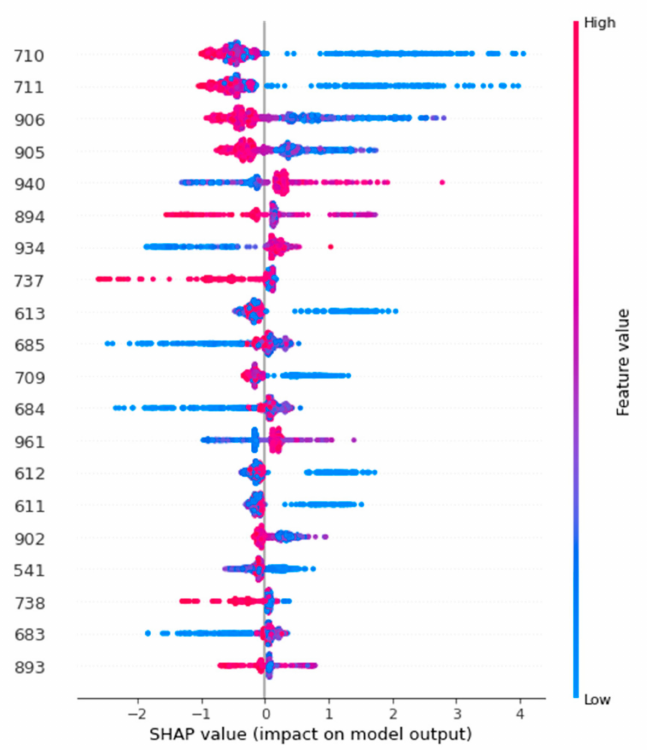
Figure 13. Shapley additive explanations (SHAP) value analysis for NC. X-axis represents SHAP value while Y-axis represents the wavelength of the feature (Unit: nm).